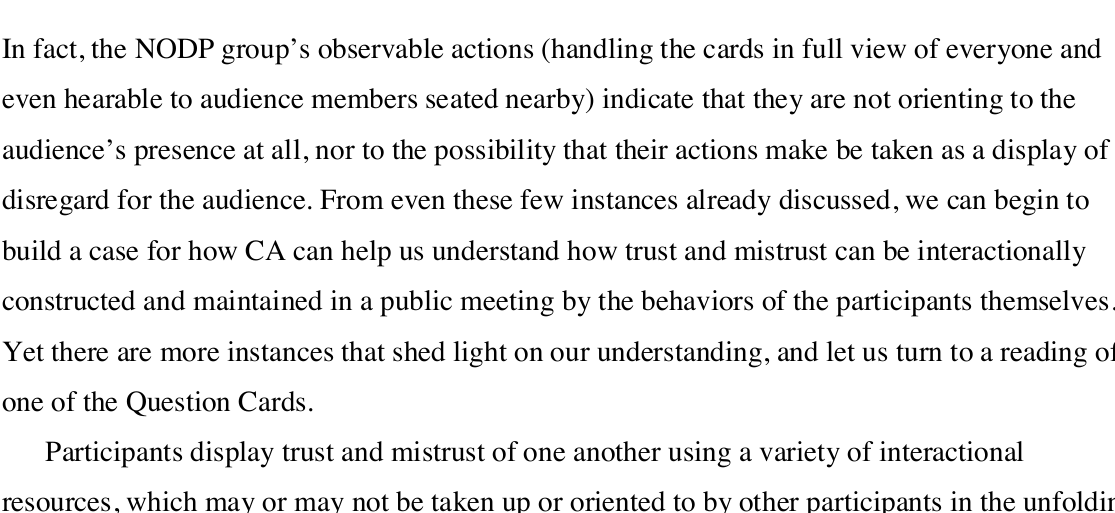
Figure 10: Visible handling of the Question Cards (at the right) [start 25:27 – end